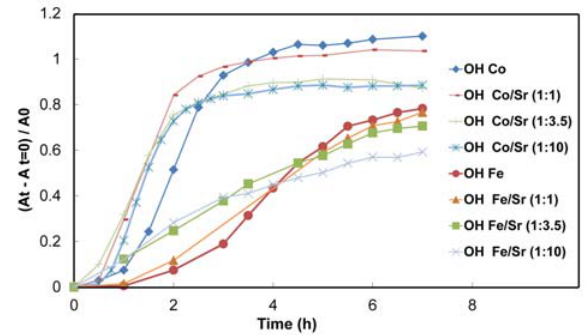
Figure 5. Monitoring of -OH group (band at 3450 cm –1 ) during au- toxidation process of HS alkyd coatings with different drier combi-